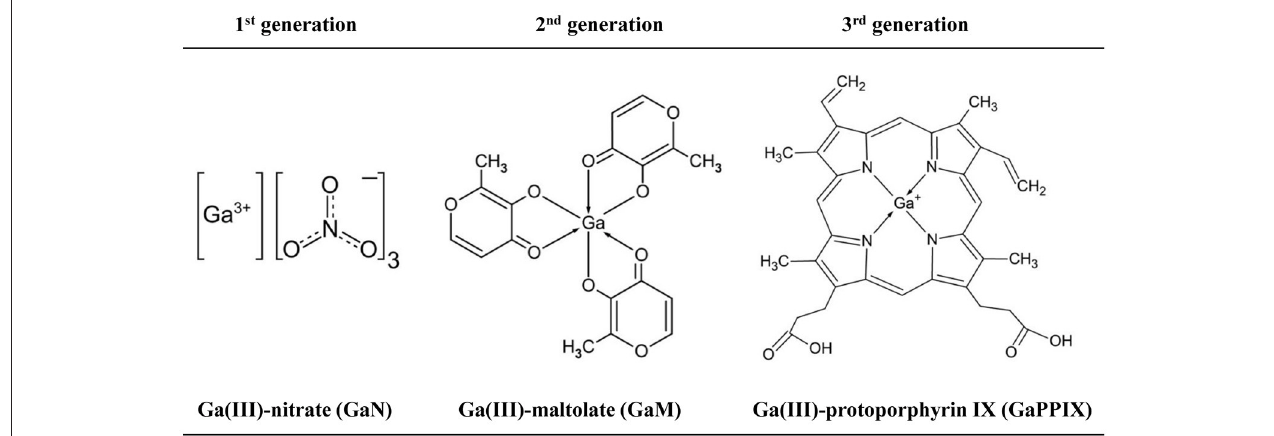
FIGURE 1 | Chemical structures of the three Ga(III) compounds used in this